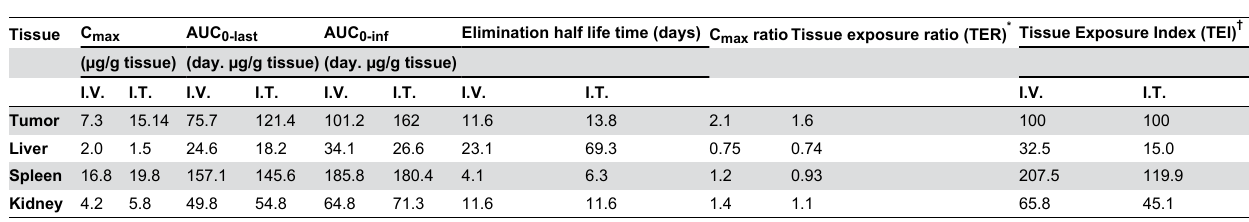
Table 1. Tissue distribution of gold nanorods after I.V. and I.T. administration in tumor bearing animals.